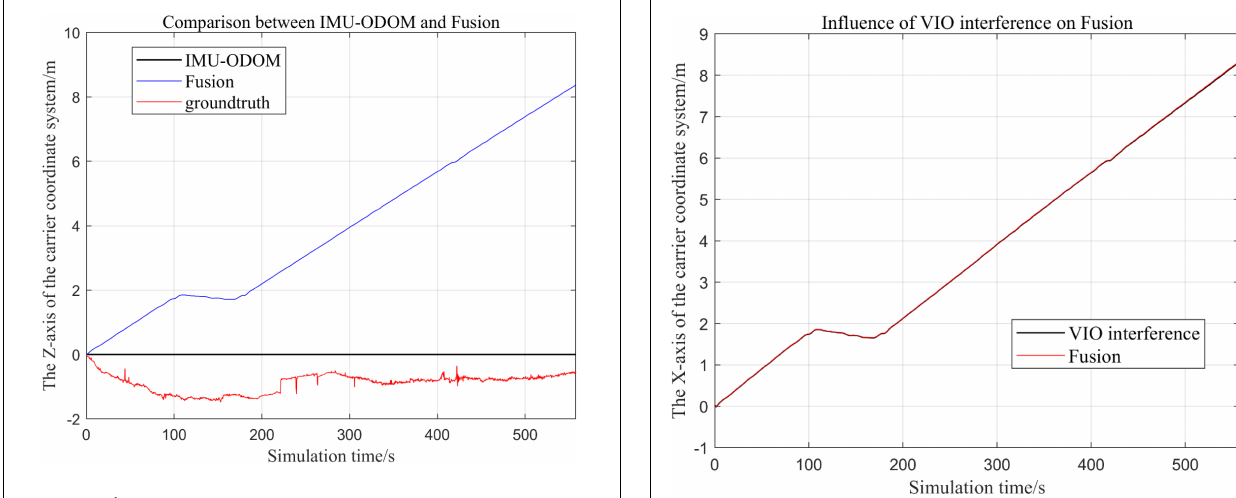
FIGURE 13 | Overall trajectory in z-axis of fusion algorithm with IMU and ODOM fusion algorithm.